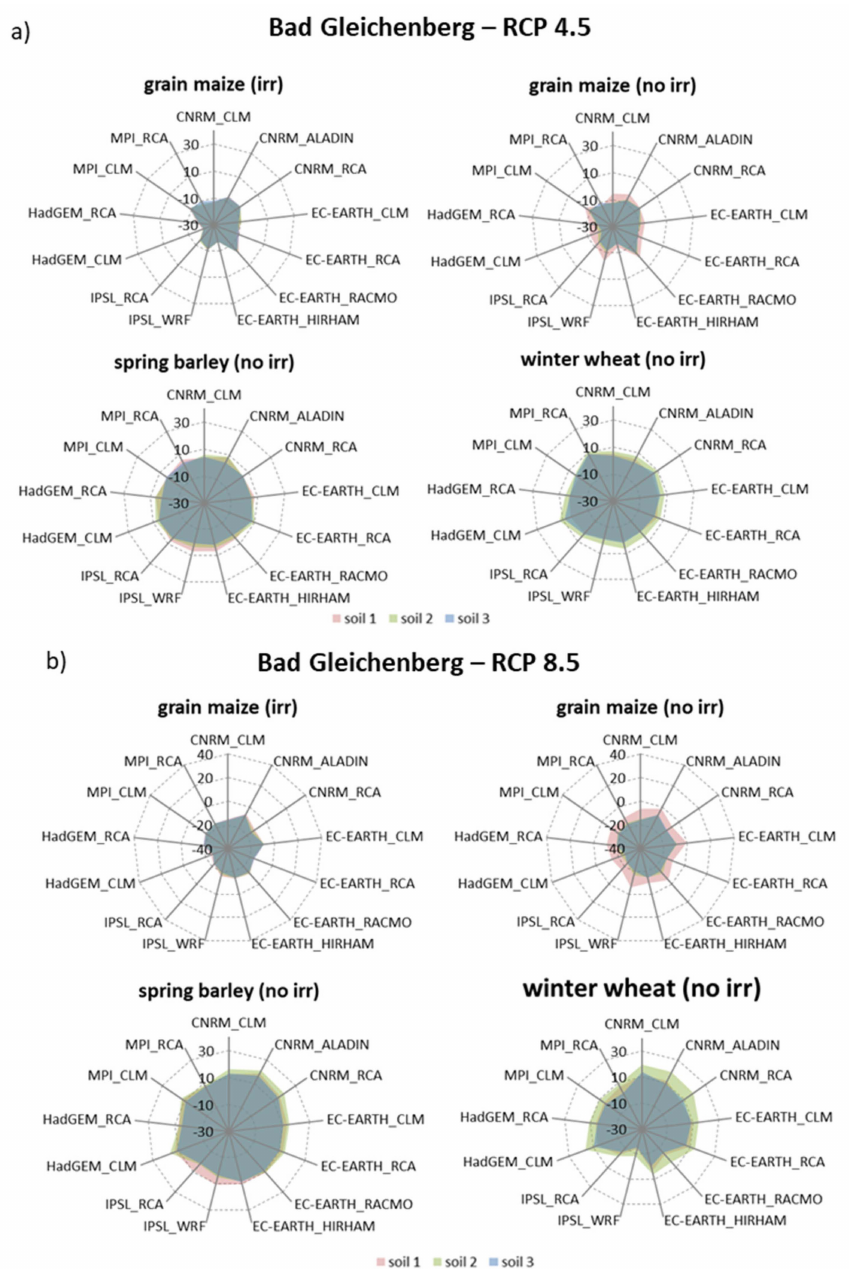
Figure 7. ÖKS15 projection-based simulated yield differences (2071–2100 vs. 1981–2010) for grain maize (optimal irrigated = irr; rainfed = no irr), spring barley (no irr), and winter wheat (no irr) for the three different soil classes (soil 1 = pink, soil 2 = green, soil 3 = blue) (RCP 4.5 ( a ) and RCP 8.5 ( b )) at the Bad Gleichenberg weather station